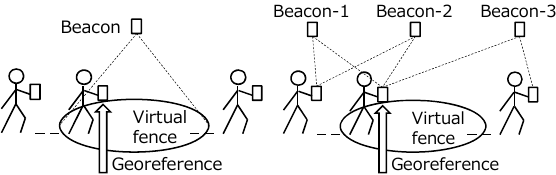
Figure 2. Geofencing using beacons (left image: geofencing using the strongest signal from beacons, right image: fingerprint-based geofencing using beacons)